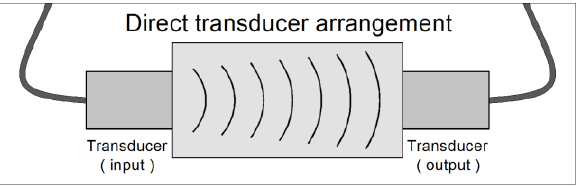
Figure 3. Scheme of the transducer arrangement used in the research.